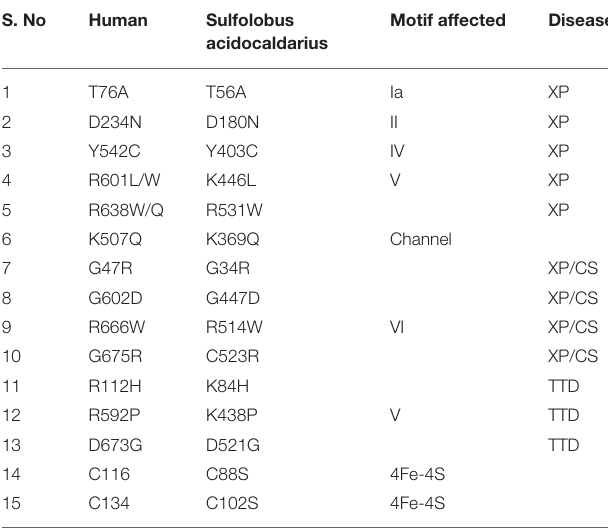
TABLE 3 | Most common mutations affecting XPD